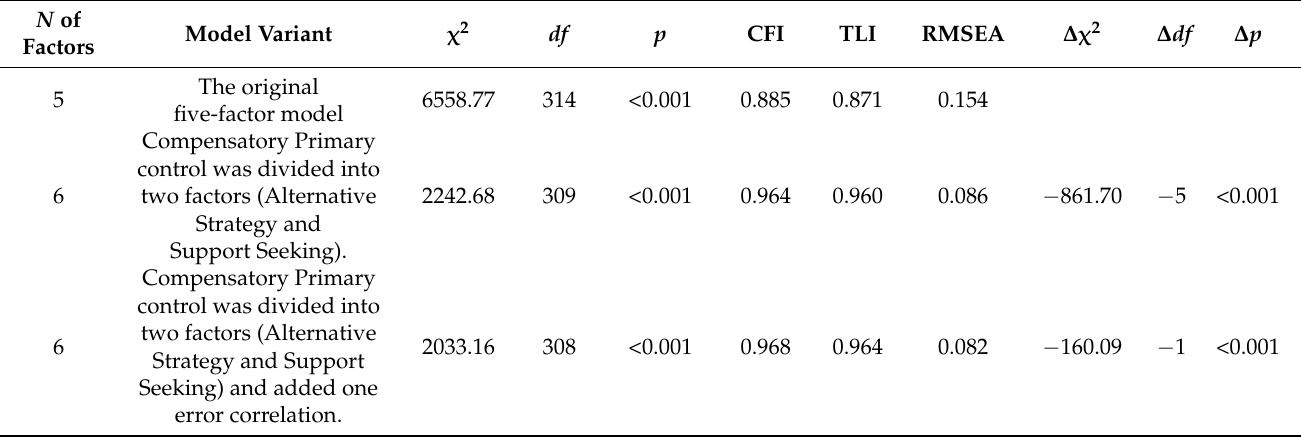
Table 1. Comparison of the robust goodness-of-fit indices of configural invariance models among four